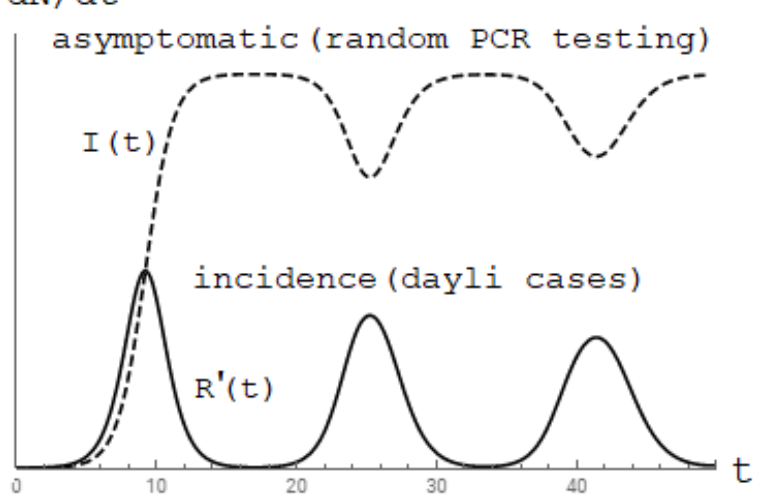
Figure 8. Share of asymptomatic infected 𝑰(𝒕) and incidence 𝑹′(𝒕) are oscillating in